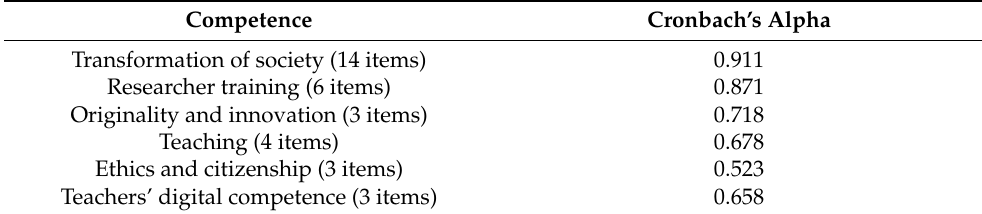
Table 4. Cronbach’s Alpha of Scale for Each Research-professor